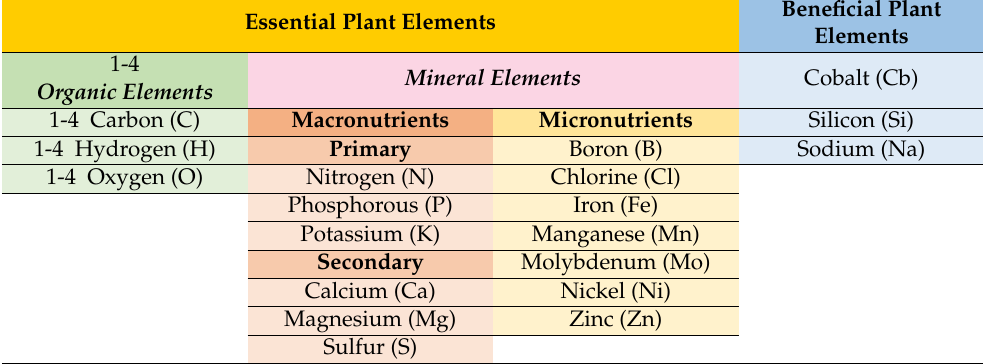
Table 2. Nutrients for plant growth (adapted from [22]).